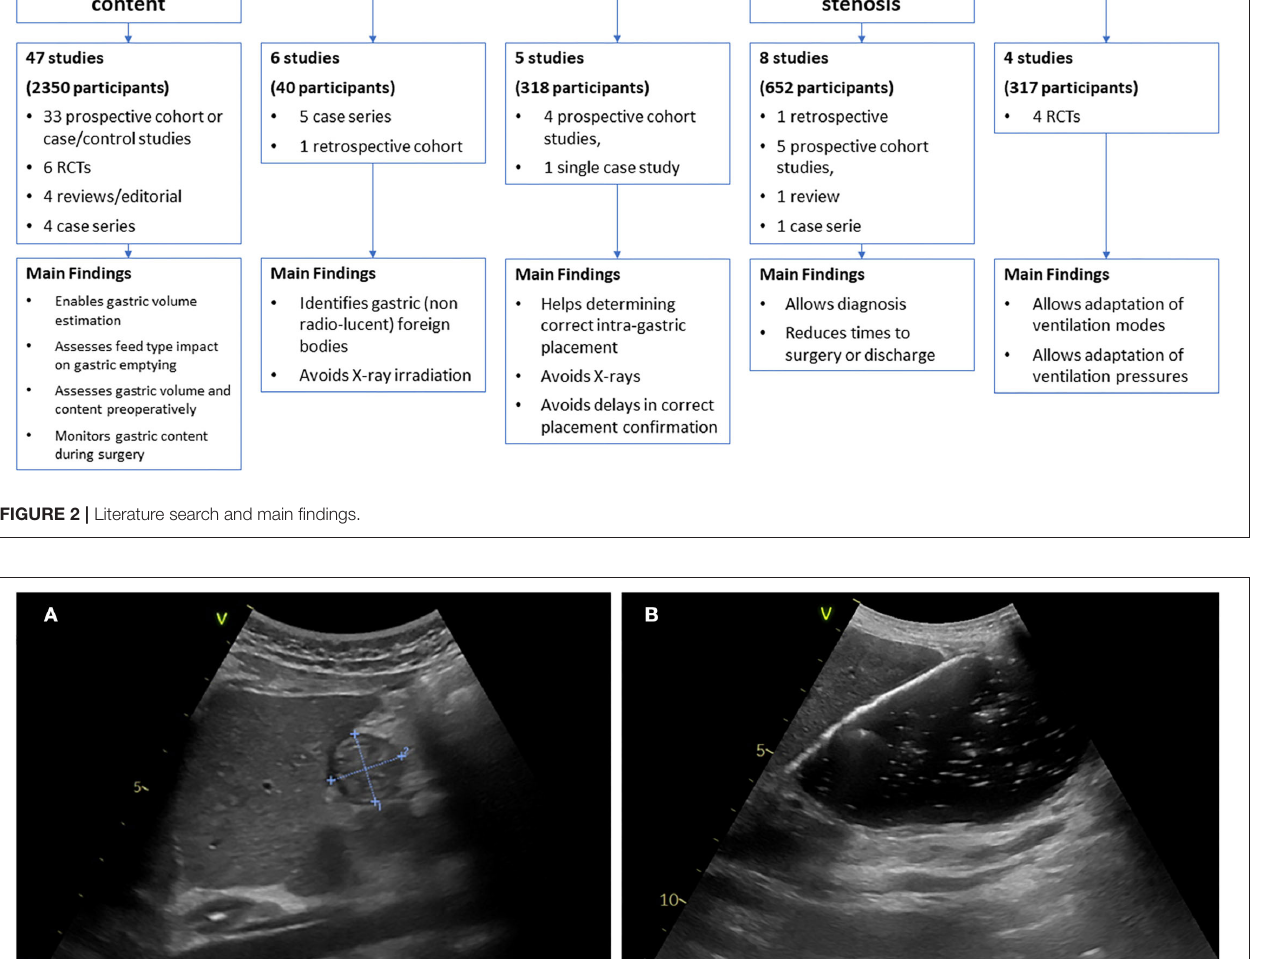
(16, 50, 54, 78); < 1 h after clear fluids (21); and < 90 min